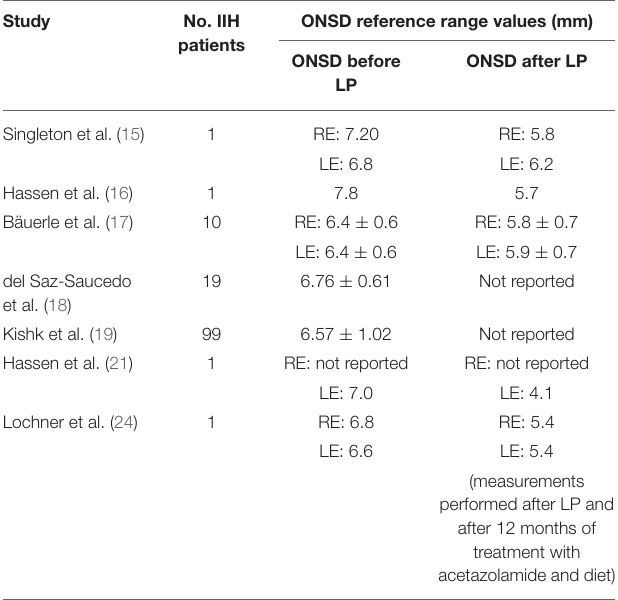
TABLE 1 | Summary of the optic nerve sheath diameter (ONSD) ultrasound reference range values established in studies on people with idiopathic intracranial hypertension (IIH) before and after lumbar